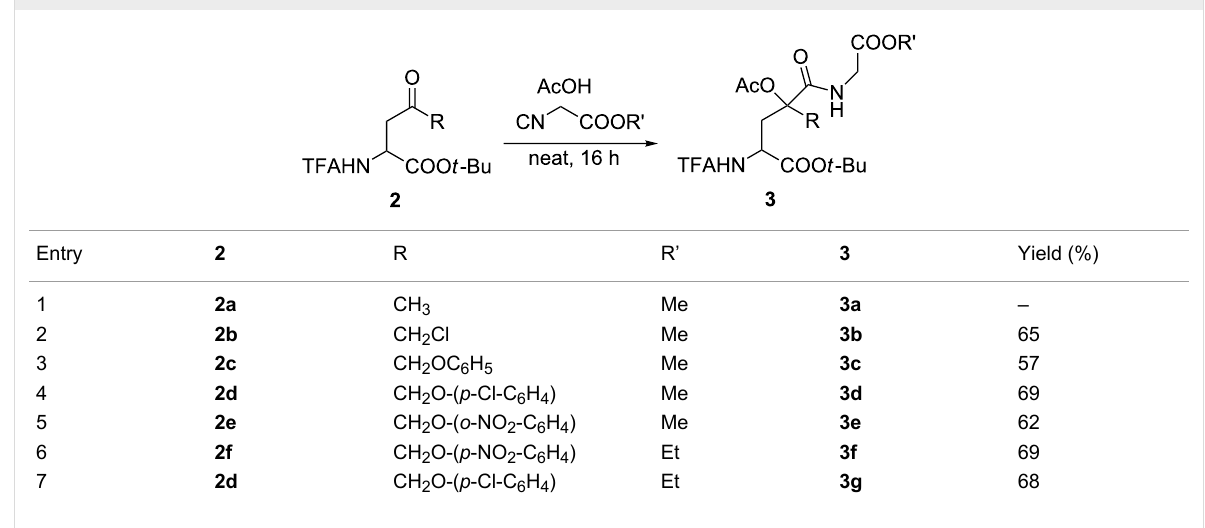
Table 2: Passerini reactions of γ -oxo-amino